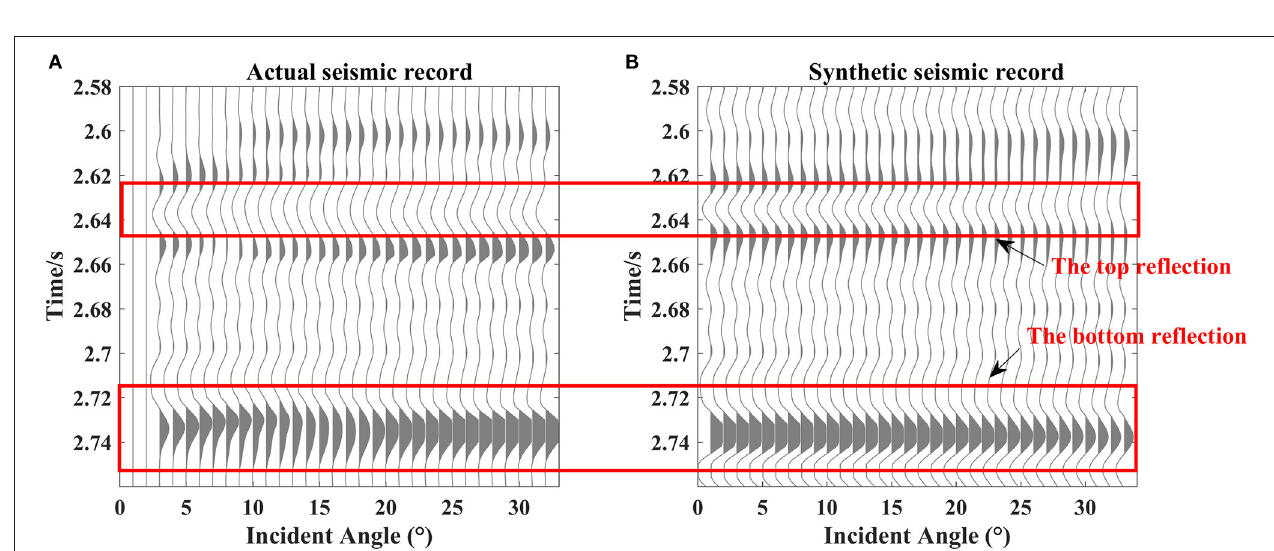
FIGURE 12 | The lithology information (the mud-rich source rock in gray and sandstones in yellow), actual physical properties (blue curves), and estimated elastic properties (green curves) of actual well L3. (A) Mud content, (B) TOC content, (C) P-wave velocity, (D) S-wave velocity (E) Density.